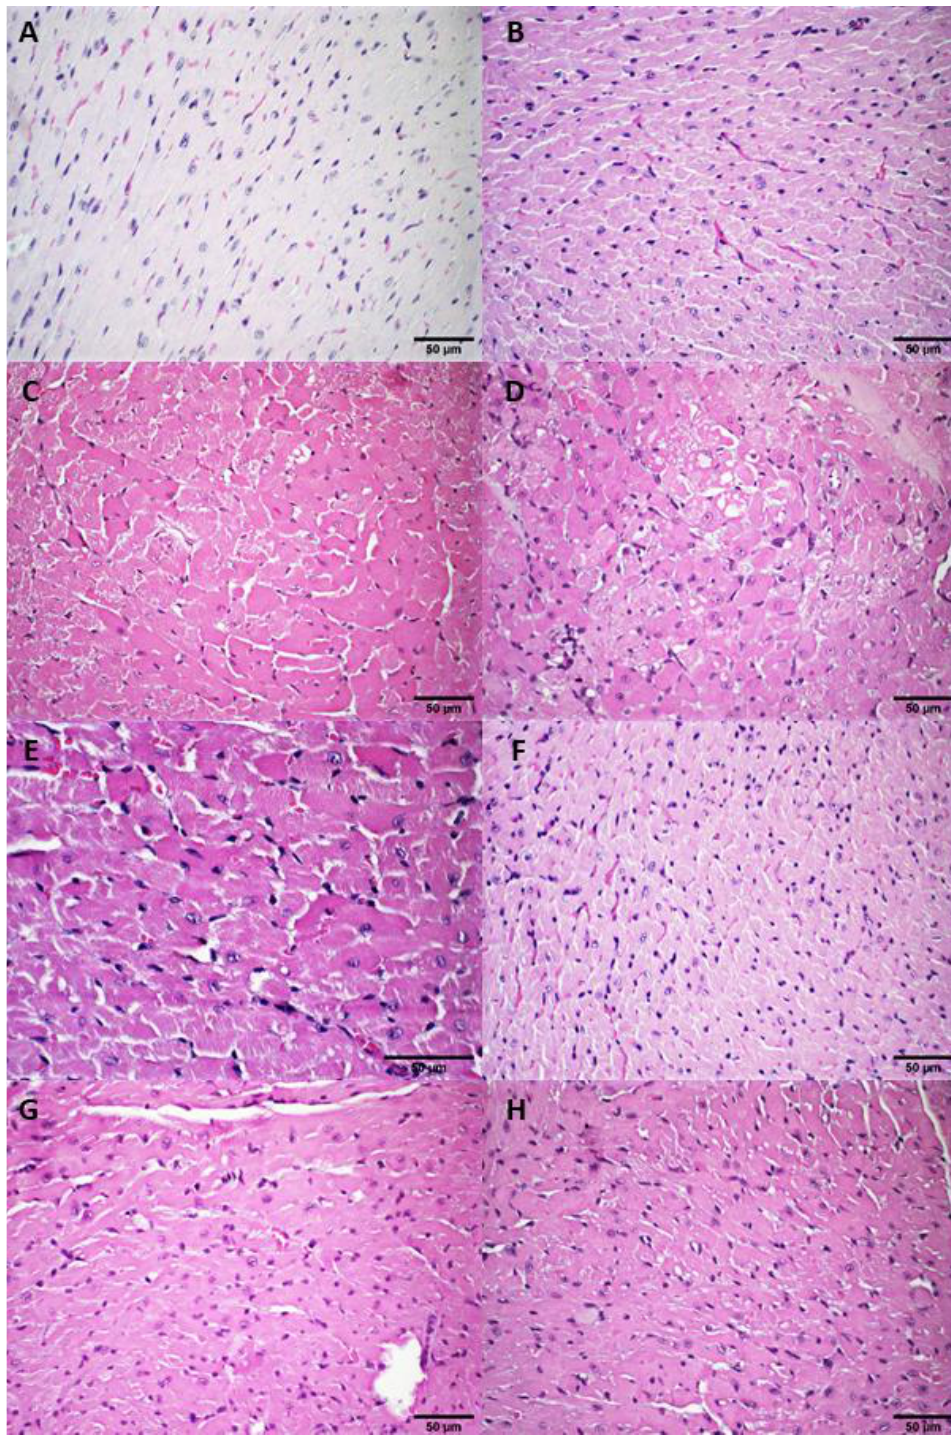
Figure A6. Histological sections of female Balb/c mice heart. ( A ) Control group (HBS), ( B ) ExoSpHL, and ( C ) DOX at a dose of 10 mg/kg, ( D ) DOX at a dose of 12.5 mg/kg, ( E ) SpHL-DOX at a dose of 15 mg/kg, ( F ) ExoSpHL-DOX at a dose of 15 mg/kg, ( G ) SpHL-DOX at a dose of 17.5 mg/kg, ( H ) ExoSpHL-DOX at a dose of 17.5 mg/kg.